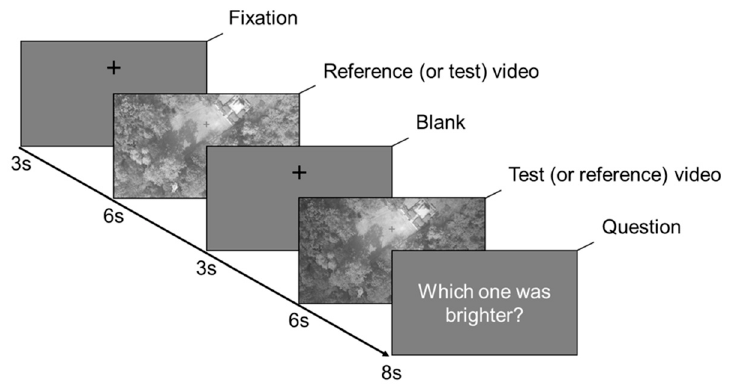
Figure 6. Schematic diagram of the assessment unit.